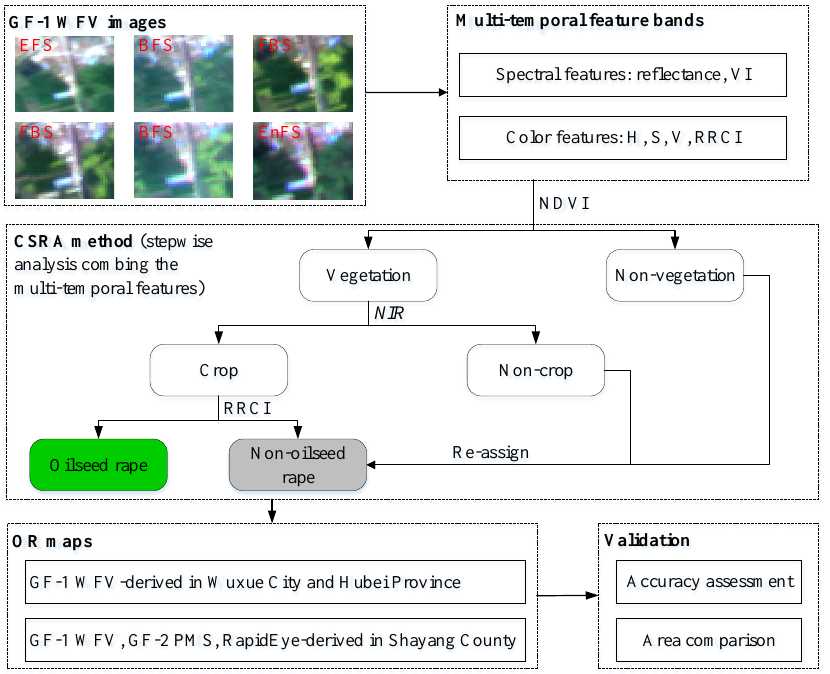
Figure 5. The workflow of this